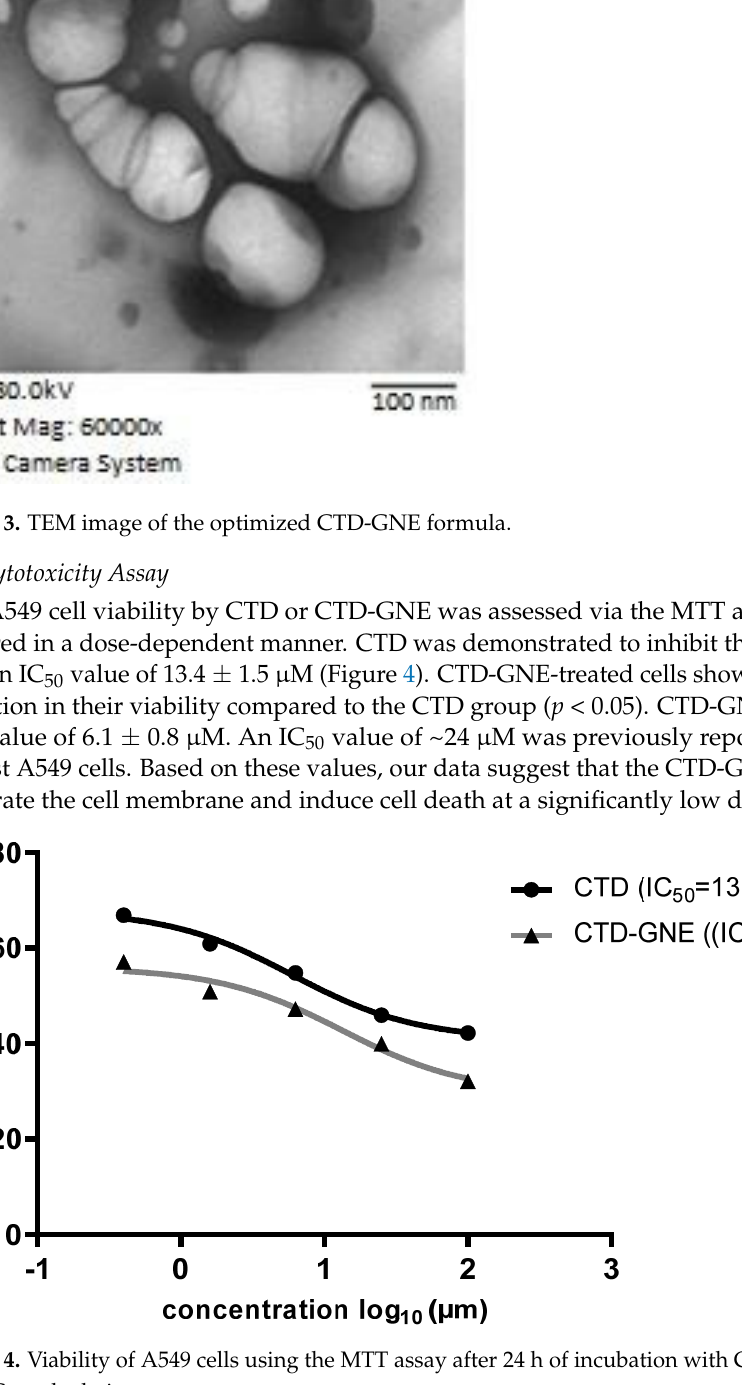
Figure 4. Viability of A549 cells using the MTT assay after 24 h of incubation with CTD or CTD- with IC 50